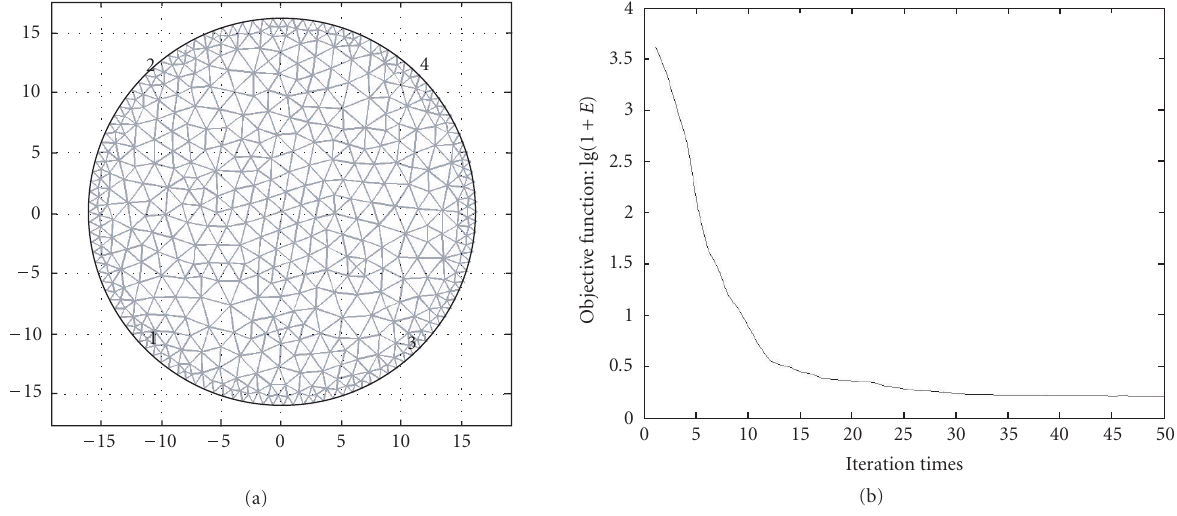
Figure 2: (a) shows the finite-element mesh used in the simulation. In (b), X axis is the CG iteration number, Y axis is the value of lg(1+ E ), representing the logarithm of objective function E